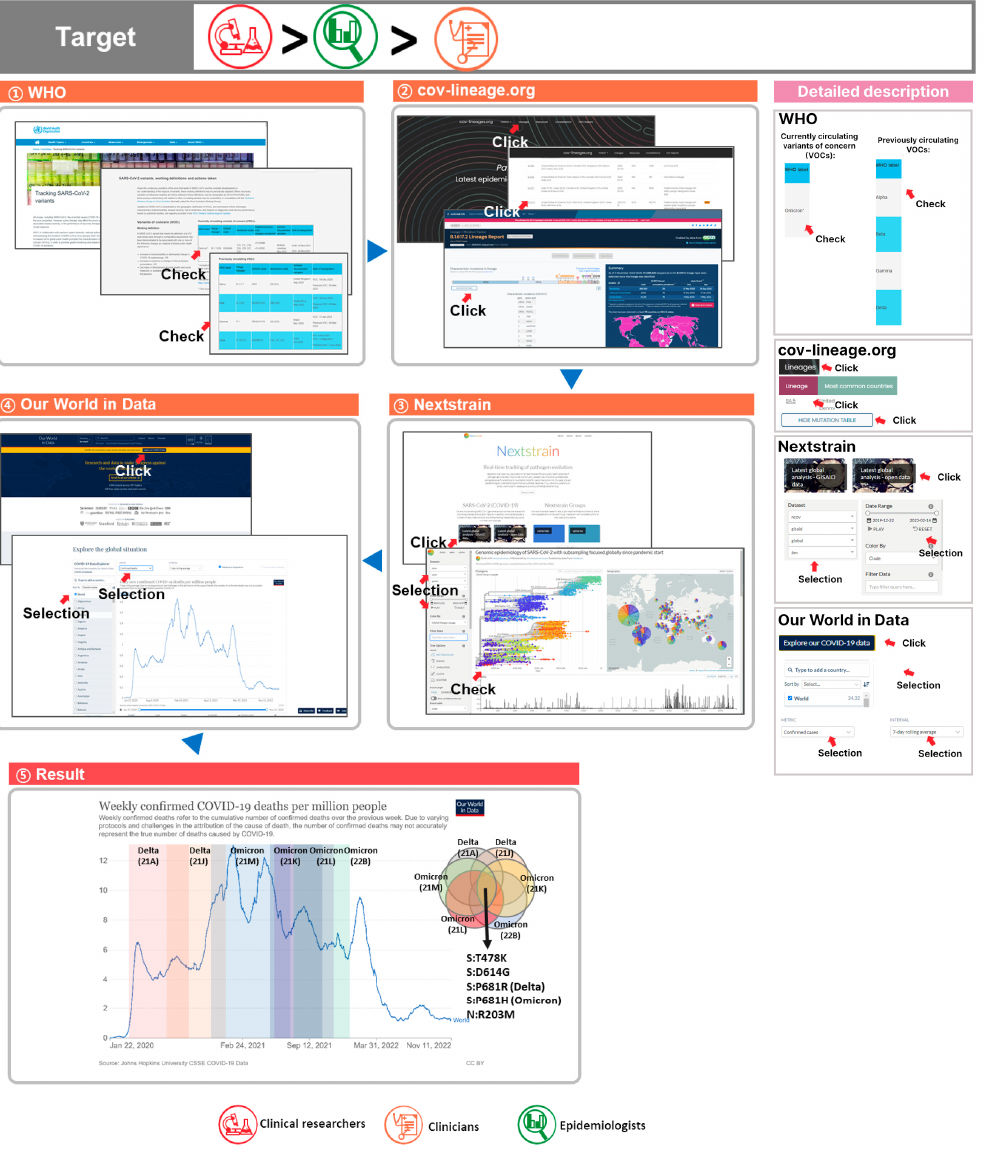
Figure 2. Comprehensive utilization of COVID-19 databases 1. Through an analysis of variants and deaths in certain periods of time, the extraction of important variants was carried out in the following process.